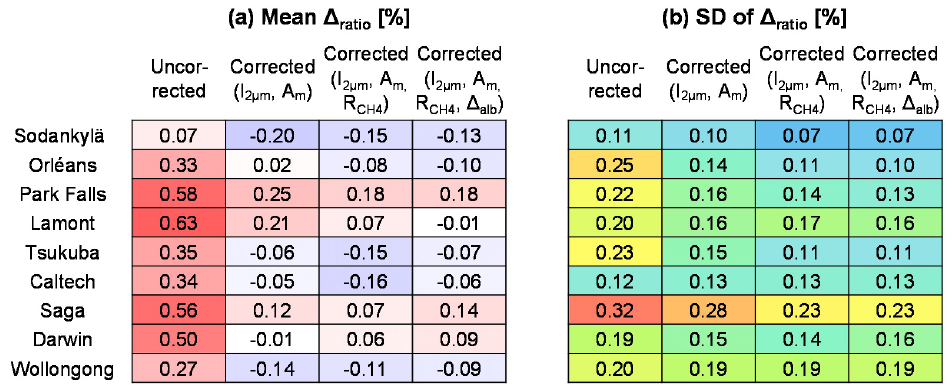
Figure 11. ( a ) Mean and ( b ) standard deviation (SD) of the mean values of relative difference in the ratio component between GOSAT and TCCON ( Δ ratio ) calculated for individual seasons (each season in each year) for each TCCON site. Results for the bias-uncorrected and bias-corrected ratio component (corrections using two, three, and four variables) are presented. The color in the figure corresponds to the Δ ratio value (blue: large negative value; white: zero; red: large positive value) and the SD value (blue: zero; red: large value) for the mean and SD, respectively.